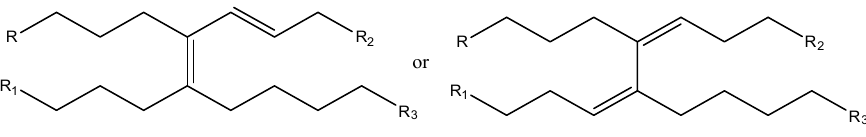
Figure 5. Isomeric products containing tri and or tetrasubstituted double bonds.